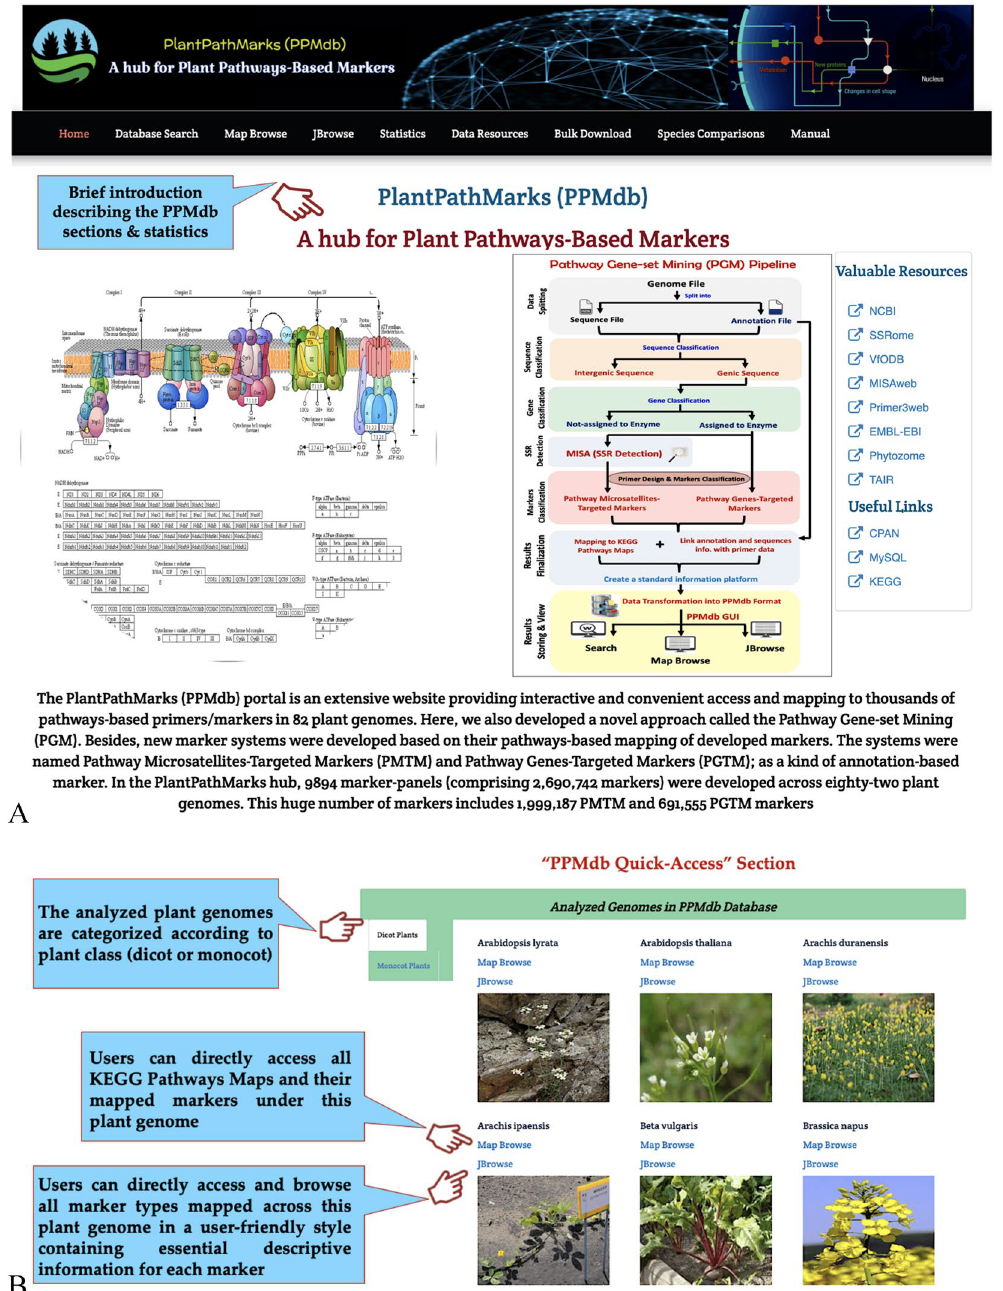
Figure 2. Screenshot of the PPMdb homepage ( A ) Database description and ( B ) PPMdb Quick-Access